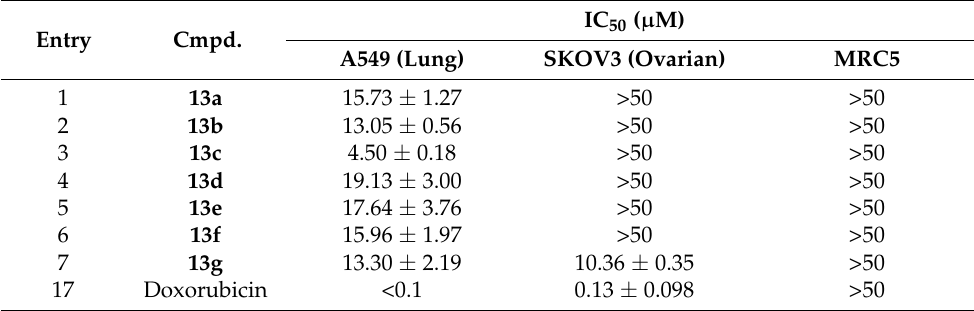
Table 2. Antiproliferative activity of 3-hydroxy γ -lactam derivatives 13